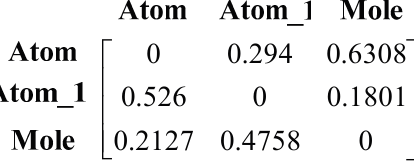
Figure 7. Association matrix of high-level FCM of Mutagenesis in BK 2